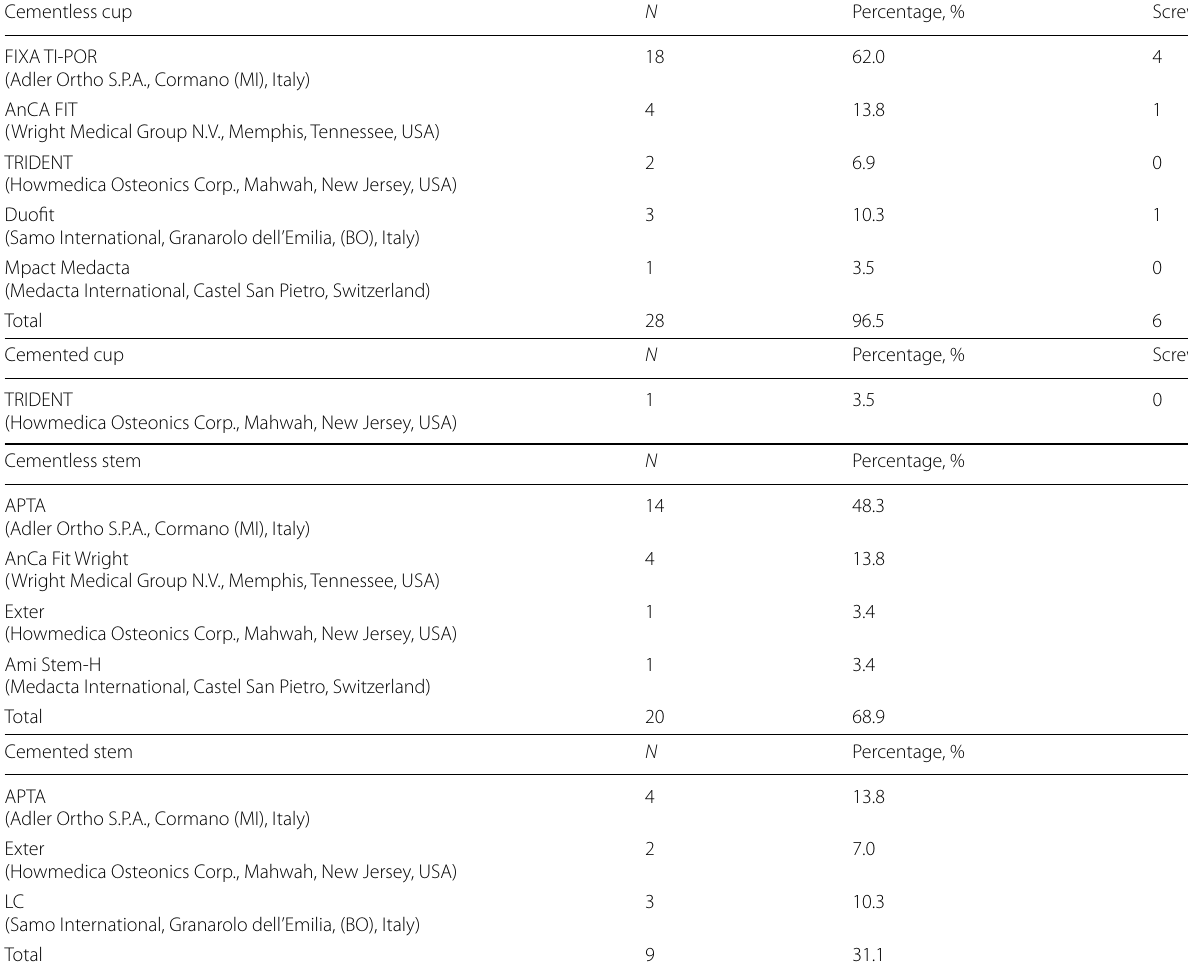
Table 3 Choice of implant design, fixation Cementless